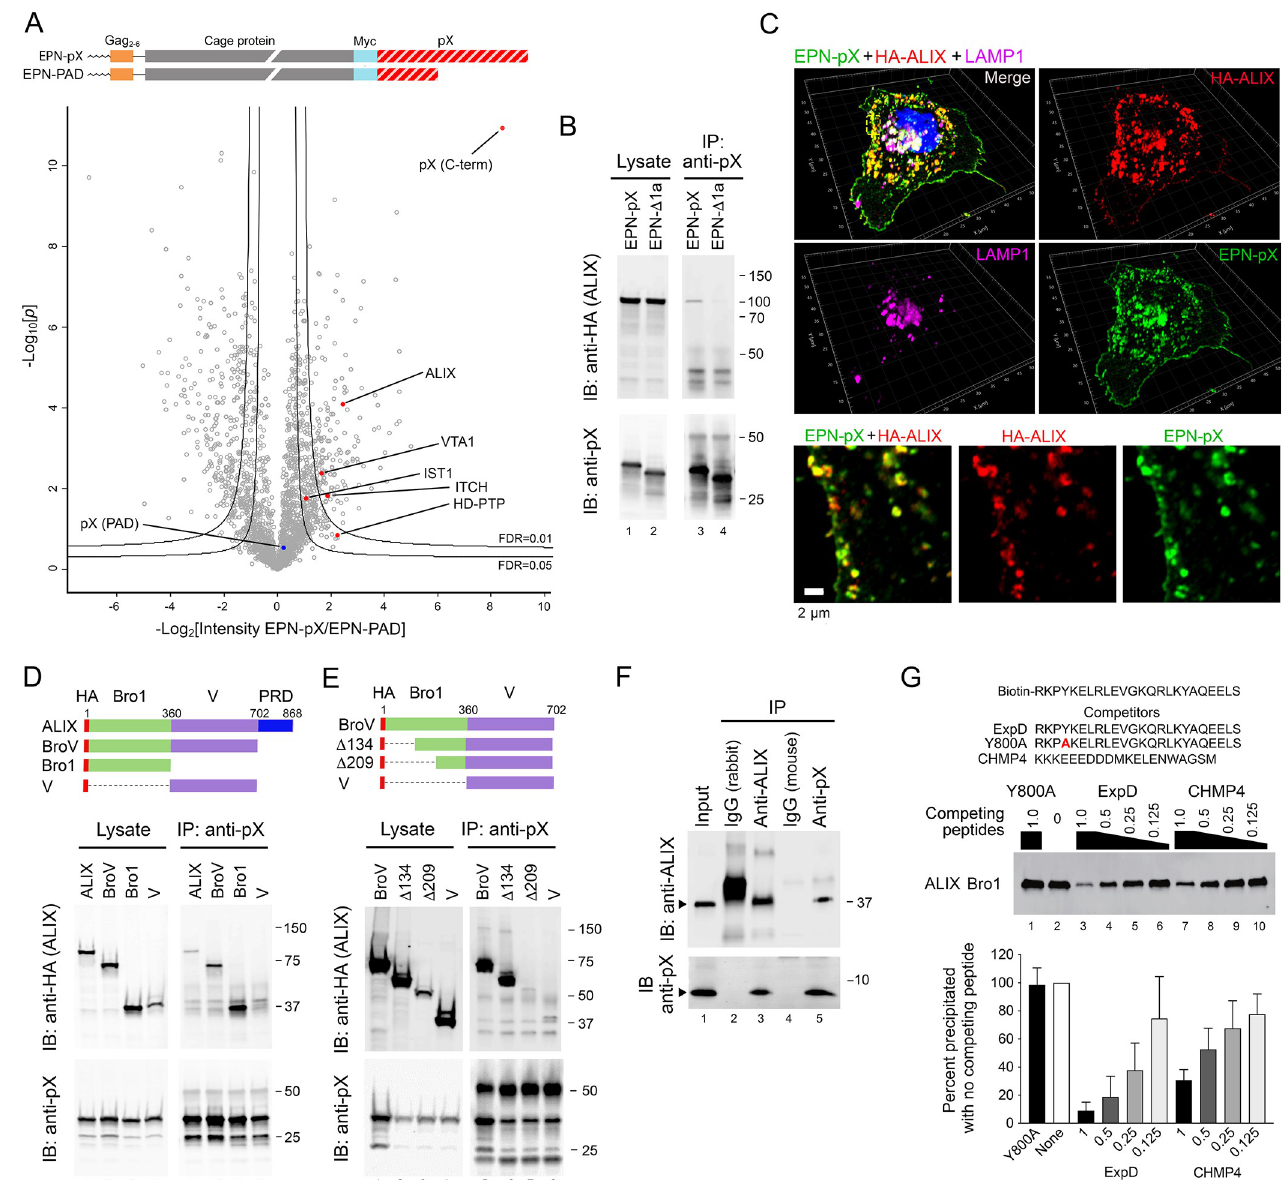
Fig 4. pX interacts directly with the Bro1 domain of ALIX. (A) EPN-pX constructs expressed in 293T cells for label-free quantitative (LFQ) proteomic analysis of the pX interactome. Below is a volcano plot showing differential abundance of proteins (LFQ intensities) identified in anti-Myc precipitates of EPN- pX versus EPN-PAD lysates. Differences in normalized LFQ peptide intensity are plotted versus significance ( p value). Lines represent lower limits of FDR < 0.01 and < 0.05. Each protein is represented by a single data point with proteins of interest labelled. (B) Co-immunoprecipitation of HA-tagged ALIX with EPN-pX. Proteins in lysates of 293T cells transfected with EPN-pX or EPN- Δ 1a were immunoprecipitated with anti-pX, followed by blotting with ( top ) anti- HA (ALIX) and ( bottom ) anti-pX. Whole cell lysates are on the left. IP: immunoprecipitation; IB, immunoblot. (C) Merged, single-channel Airyscan fluorescent images of a cell transfected with EPN-pX and HA-ALIX expression vectors, showing pX (green), ALIX (HA, red) and LAMP1 (magenta). At the bottom are shown enlarged dual- and single-channel recordings of the region delineated by the yellow rectangle in the merged image at the top. (D,E) Co- immunoprecipitation of HA-tagged ALIX or the indicated ALIX domain fragments ( top ) with EPN-pX expressed in 293T cells. (F) Co-immunoprecipitation of bacterially-expressed pX and 6XHis-tagged ALIX Bro1 protein (residues 1–392) mixed in buffer containing 0.7% BSA and 0.07% Tween-20. The input mixture (lane 1) was precipitated with the indicated antibodies, followed by immunoblotting as shown. IgG = isotype control. (G) Biotin-tagged ExpD peptide pulldown assay. Recombinant ALIX Bro1 protein was incubated with synthetic biotin-tagged ExpD peptide ( top ), affinity isolated on streptavidin beads, and probed with anti-ALIX. Competitor peptides, representing ExpD, the Y800A ExpD mutant, and the C-terminus of CHMP4 [44] ( top ) were added to the mixture at molar ratios decreasing from 1 to 0.125 relative to the biotin-tagged peptide. At the bottom is shown a quantitative analysis of Bro1 pulled down by biotin-tagged ExpD, normalized to pulldown in the absence of competitor peptide. Results shown are means ± s.e.m. from n = 3 independent experiments.